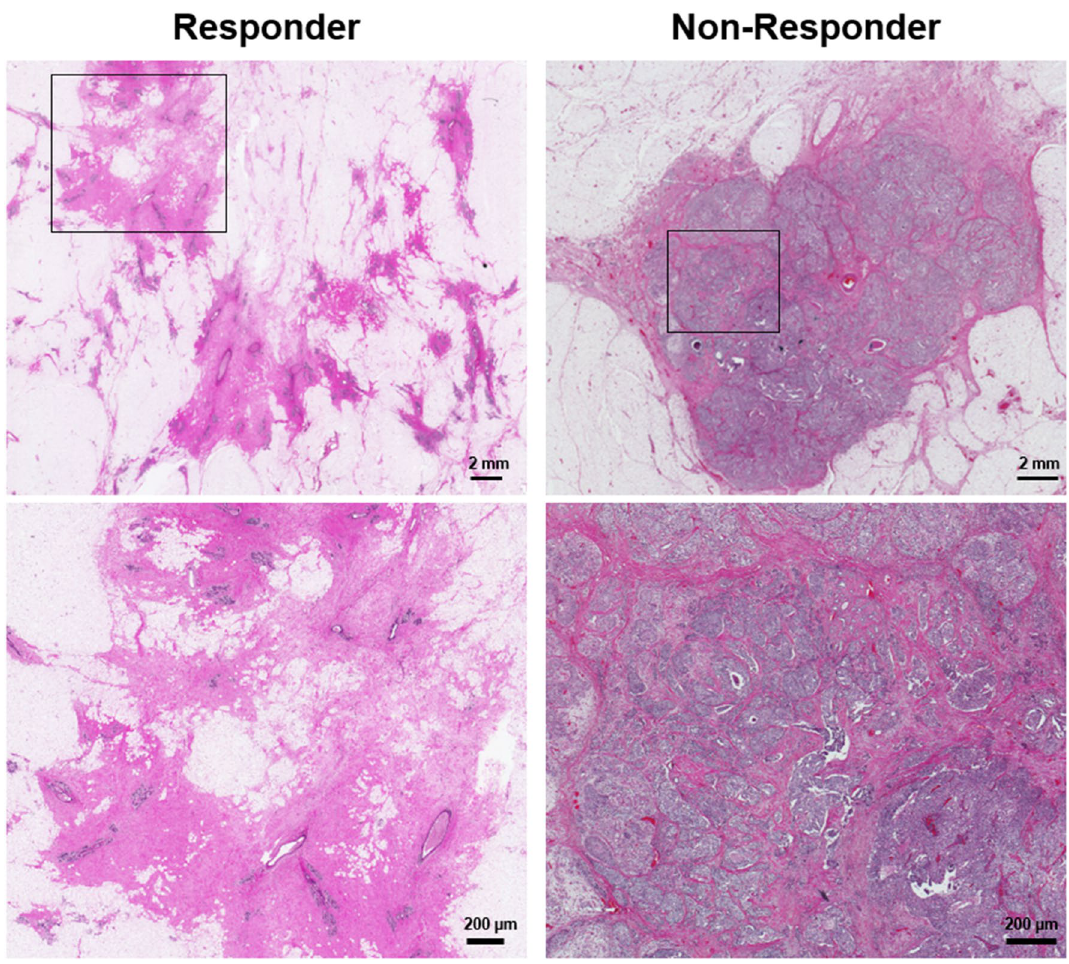
Figure 3. Whole mount histopathology images of mastectomy specimens acquired from representative responding and non-responding patients, at low (top) and high (bottom) magnifications. The scale bars represent 2 mm and 200 µm in low and high-magnification images,